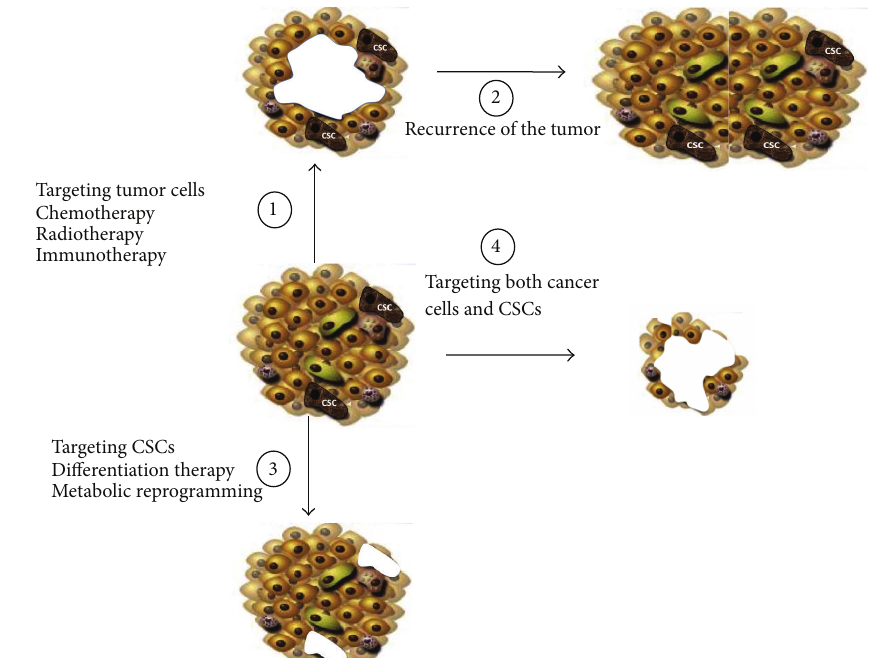
Figure 3: Needs of combinatorial therapies that target cancer cells and CSCs. A tumor is a complex mix of cancer cells including differentiated cells at different stages as well as CSCs. Current treatments kill cancer cells without affecting cancer stem cells (1). However, since CSCs are not affected, there is a major risk of tumor recurrence (2). Targeting only CSCs might result in a reduced number of matured cells but that will not be sufficient to eradicate the tumor (3). Thus, cancer therapy should ideally target both CSCs and matured cells (4) by generally increasing sensitivity to cell death of all the cell types as well as reducing the proliferation of matured cells and inducing differentiation and sensibility to cell death of